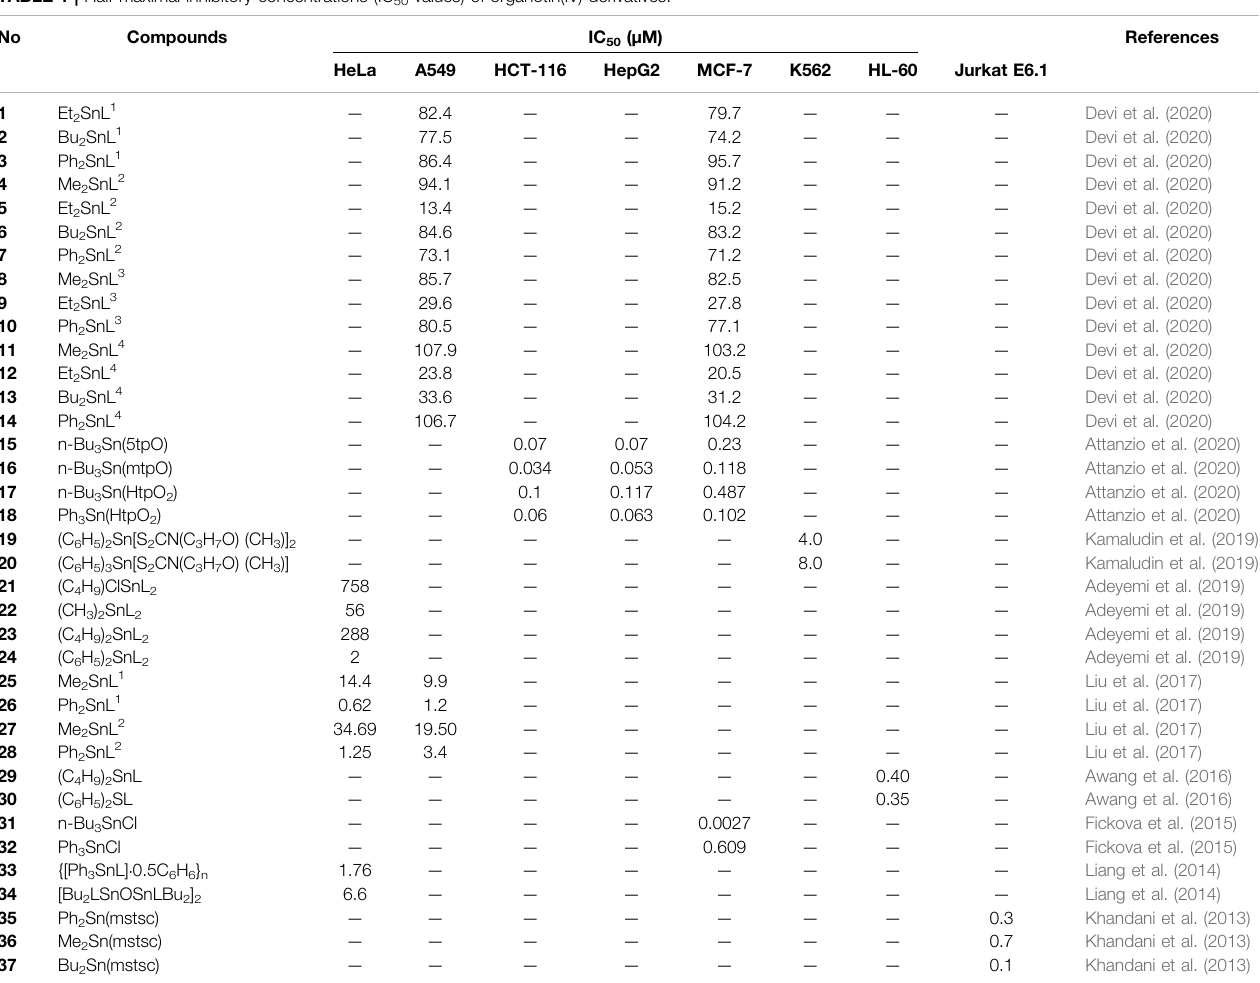
TABLE 1 | Half-maximal inhibitory concentrations (IC 50 values) of organotin(IV) derivatives. No